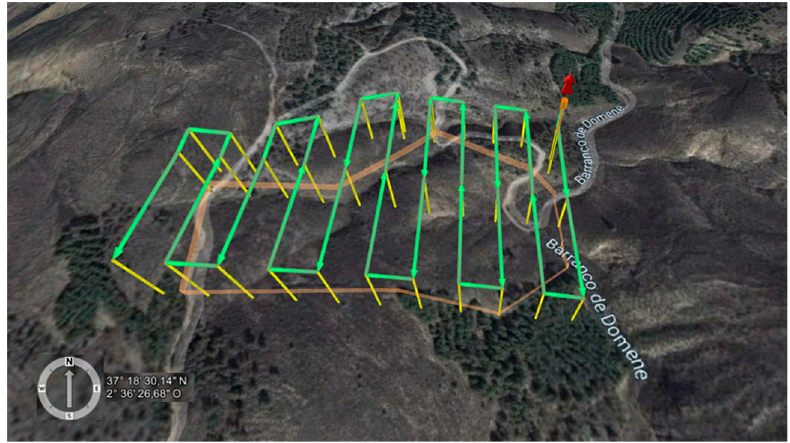
Figure 4. Flight planning with waypoints at the same 56.2 m altitude above ground level